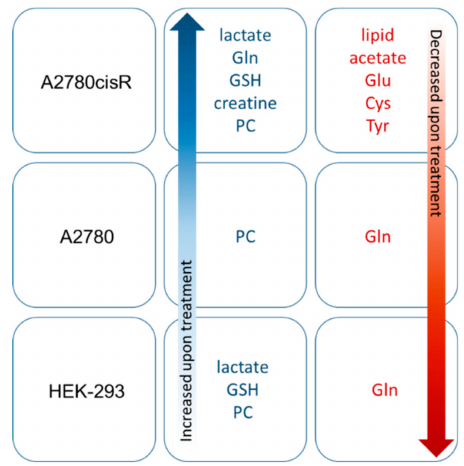
Figure 7. Summary showing the most significant changes in identified metabolites observed in the three cell lines upon treatment with DiRu-1: For a complete overview including the influence of the dose see Figures 4–6, Figures S14–S25 and Table 3.